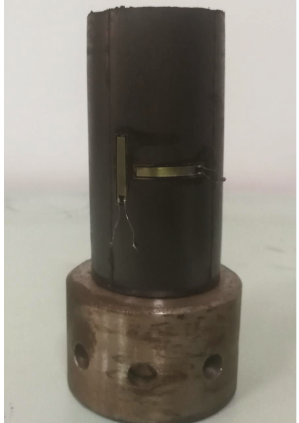
Figure 2: Well-prepared coal samples for